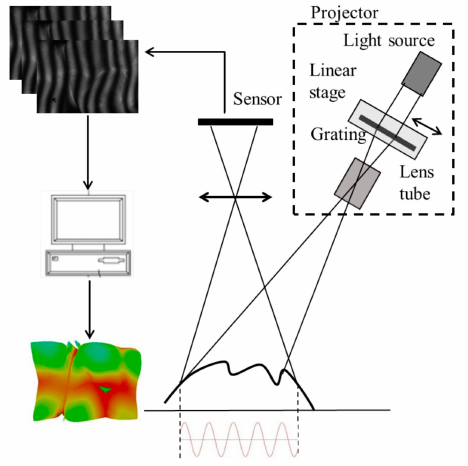
Figure 2. System setup of fringe projection